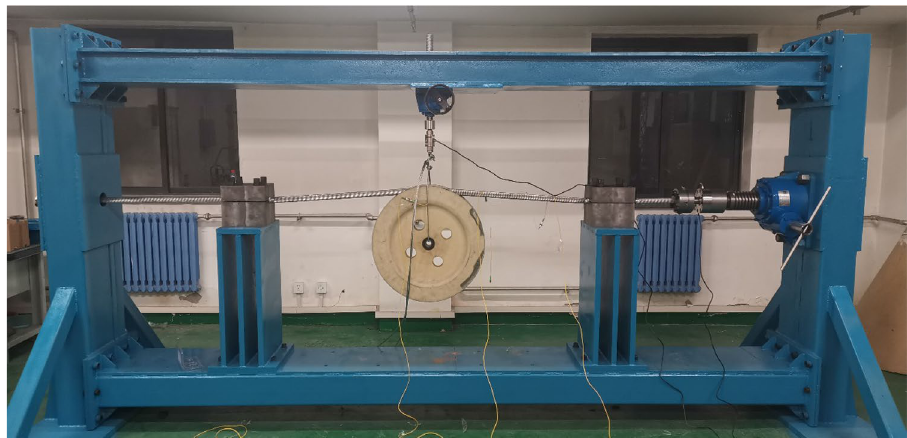
Figure 15. Mechanical test platform of conductor passing through pulley.